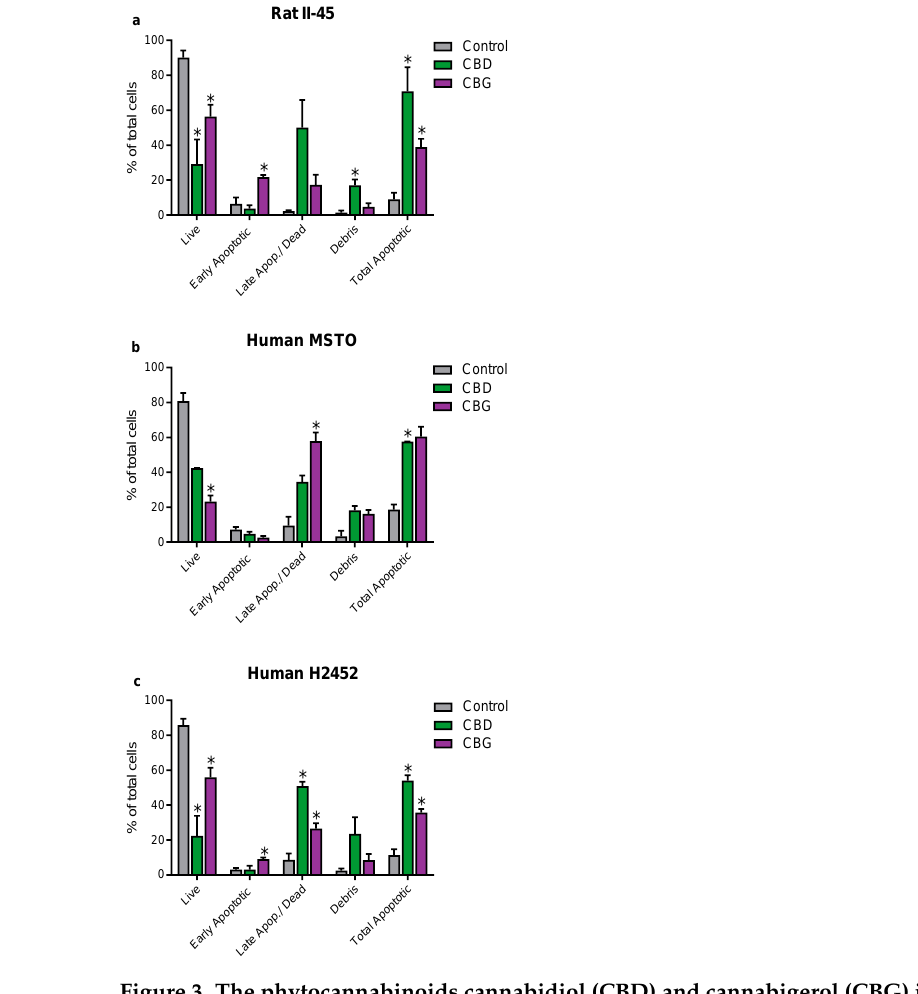
Figure 3. The phytocannabinoids cannabidiol (CBD) and cannabigerol (CBG) induced apoptosis in mesothelioma cell lines. The effects of CBD and CBG (2xIC 50 ) on apoptosis were assessed in rat II-45 ( a ), human MSTO ( b ), and H2452 ( c ) mesothelioma cell lines. After 24 h of treatment with vehicle (control), CBD or CBG, cells were harvested, and assays performed. Bars show the mean and SD from three independent experiments. p -values were calculated using two-way ANOVA Holm-Sidak’s multiple comparisons. * p < 0.05 relative to vehicle-treated control cells.